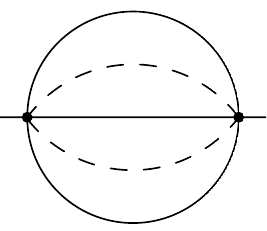
Figure 1 . The generalized sunset graph with two massless and three massive lines with the same